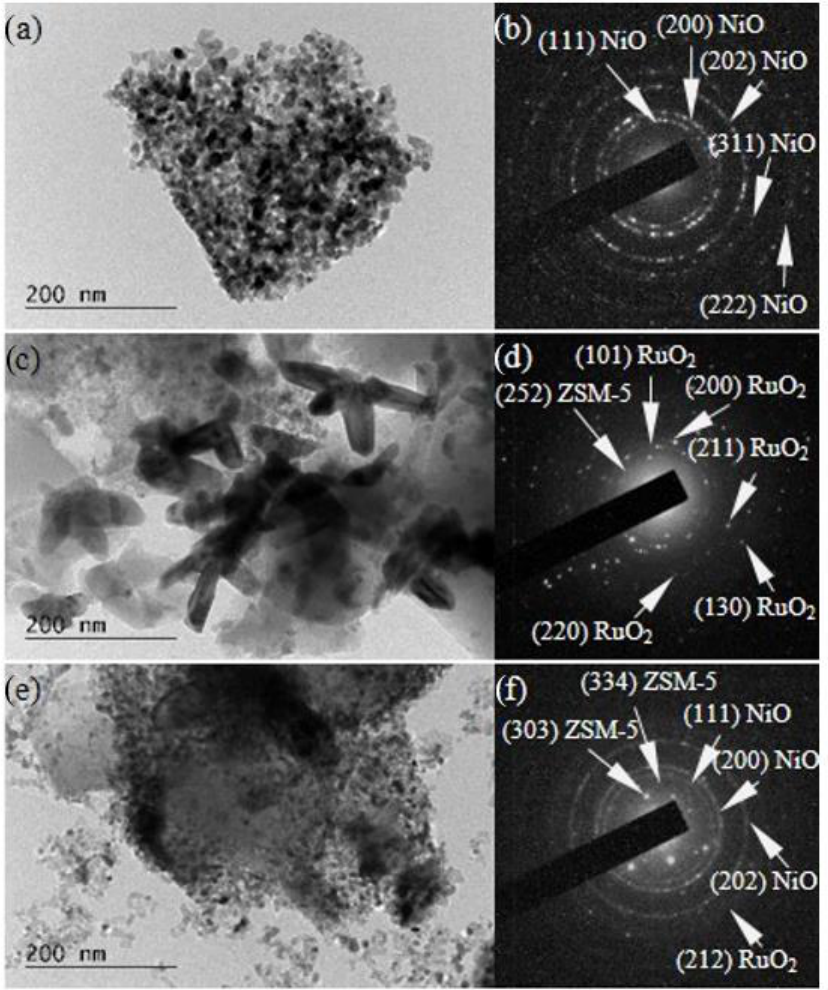
Figure 4. TEM images of 10NiZSM-5 ( a ), 5RuZSM-5 ( c ) and 5Ru10NiZSM-5 ( e ) zeolites and SAED patterns of 10NiZSM-5 ( b ), 5RuZSM-5 ( d ) and 5Ru10NiZSM-5 ( f ). The surface chemical composition was calculated from the ratio of the corresponding intensities of O 1s, Si 2p, Al 2p, Ni 2p 3/2 and Ru 3d photoelectron peaks corrected by the Scofield’s photoionization cross sections and the obtained data are presented in Table 3. The nickel content in 10Ni5RuZSM-5 is exposed to the zeolite surface and can participate in the reaction as active sites whereas only a small part of Ru is accessible for the reactant molecules. The surface nickel content is higher on the bimetallic sample and ruthenium is lower compared to monometallic varieties. The results are in good agreement with TPR data, showing easier reduction of nickel in bimetallic preparations, which can be due to the high density of nickel nanoparticles on the